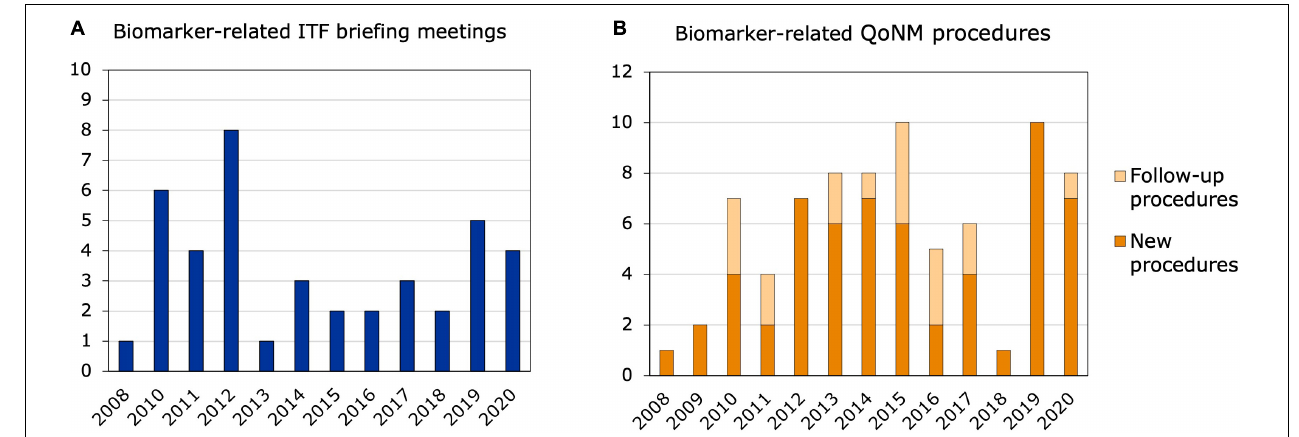
FIGURE 2 | Biomarker-related interactions between 2008 and 2020. (A) ITF briefing meetings. The bars represent ITF briefing meetings related to biomarkers and their qualification that took place from 2008 to 2020. (B) New and follow-up qualification procedures. Qualification of Novel Methodologies procedures related to biomarkers that were started between 2008 and